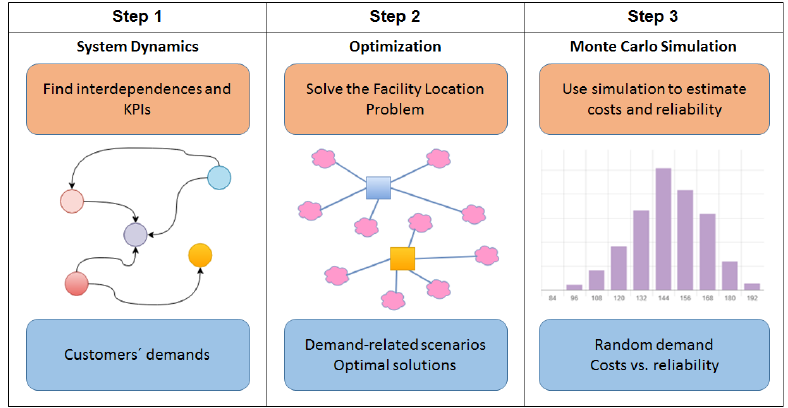
Figure 3. Schema of the integrated simulation-optimization approach.